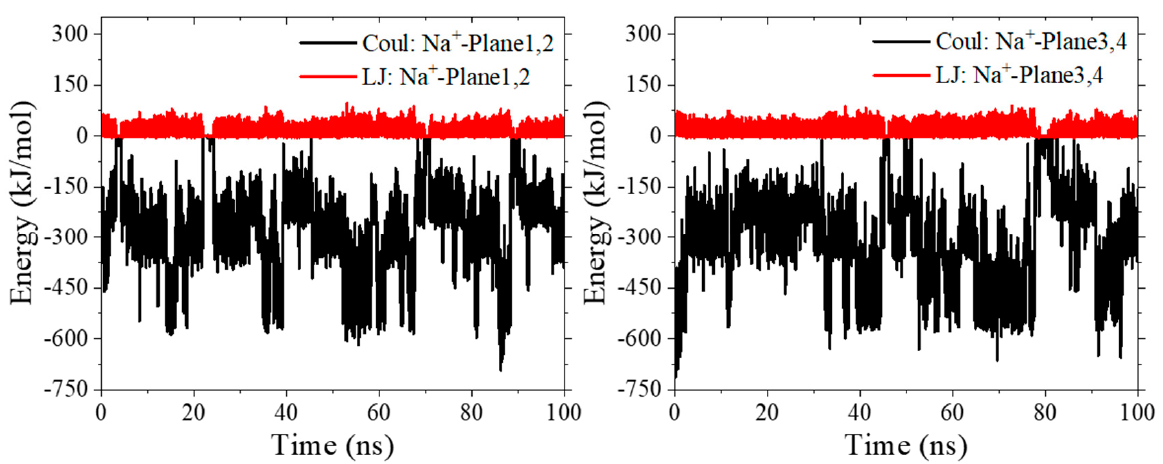
Figure 6. The time evolution of the interaction between Na + counterion and the m -HOPO units in the simulations of t -HOPO 4 − .